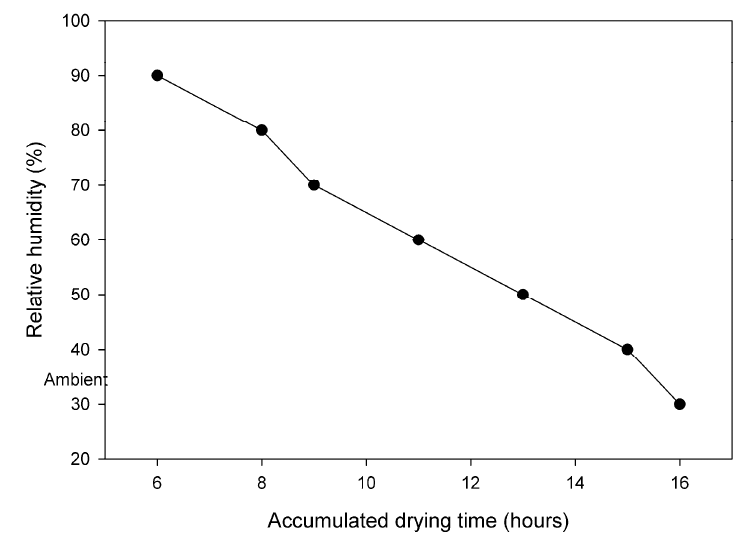
Figure 5. Accumulated time and humidity inside drying cabinet.